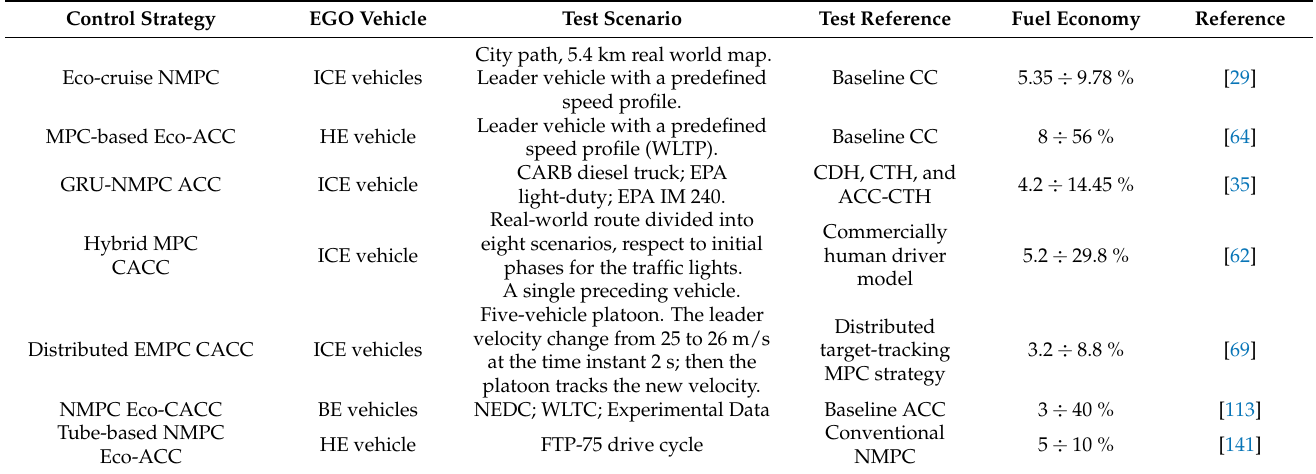
Table 2. Key features of MiL approaches for fuel economy performance